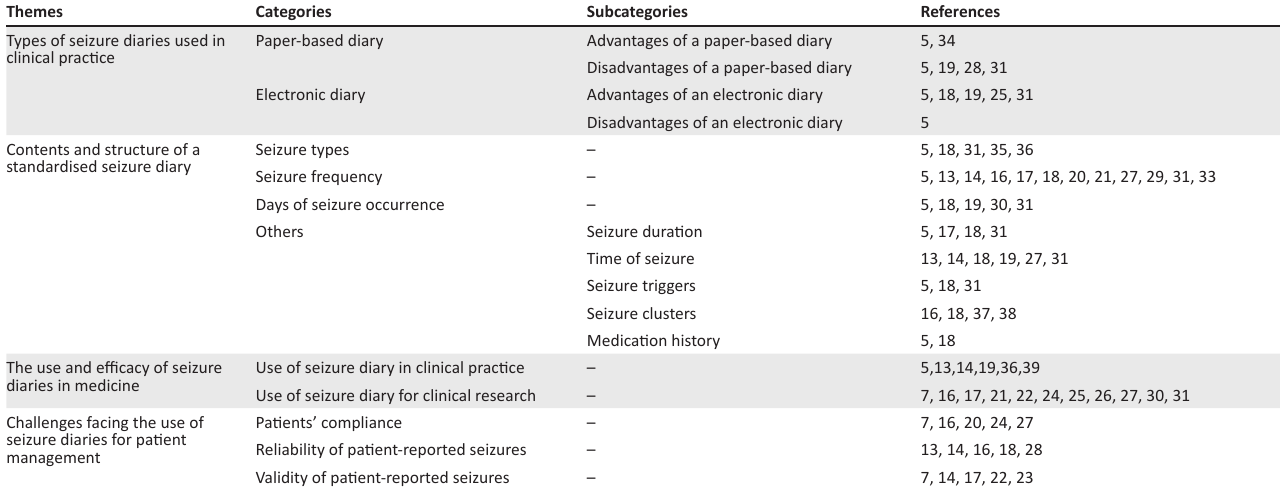
TABLE 3: Identified themes, categories and